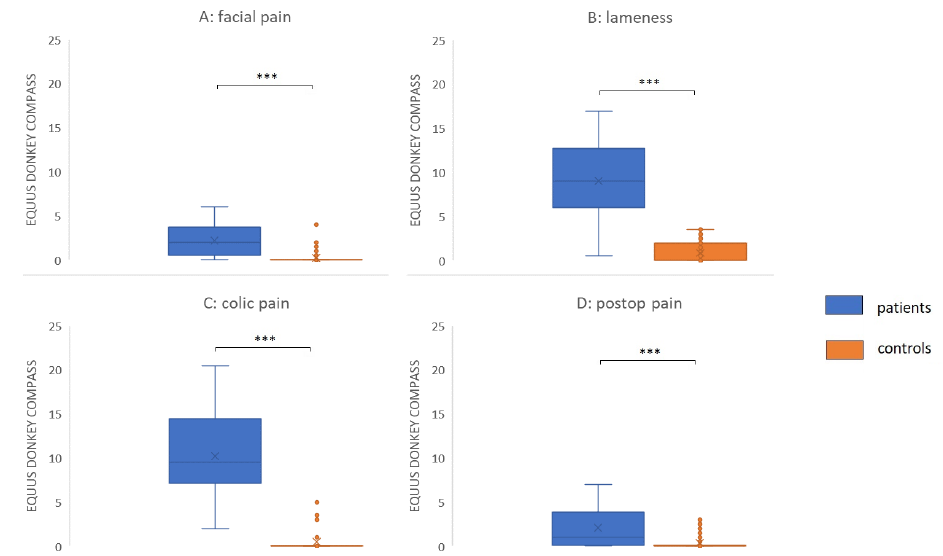
Figure 3. EQUUS DONKEY COMPASS patients versus controls. (A ) Facial pain ( n = 18 patients versus = 39 controls), ( B ) Orthopaedic pain ( n = 25 patients versus n = 68 controls); ( C ) Colic pain ( n = 12 patients versus n = 28 controls), ( D ) Postoperative pain ( n = 24 patients versus n = 50 controls). Lines in boxes show median scores; x — mean value; boxes show 25 – 75th percentiles; error bars show 5 – 95th percentiles. *** p < 0.001.